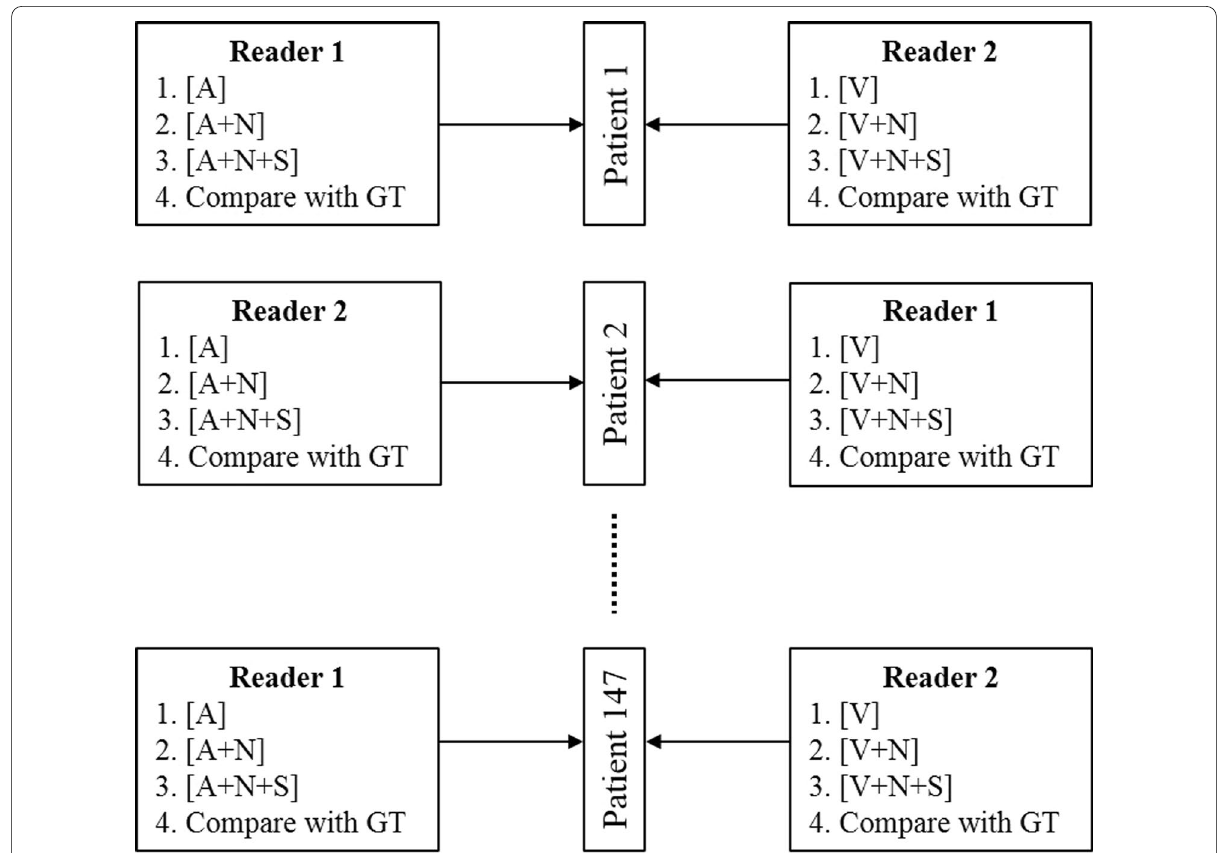
Fig. 2 Study design and image set analysis sequence